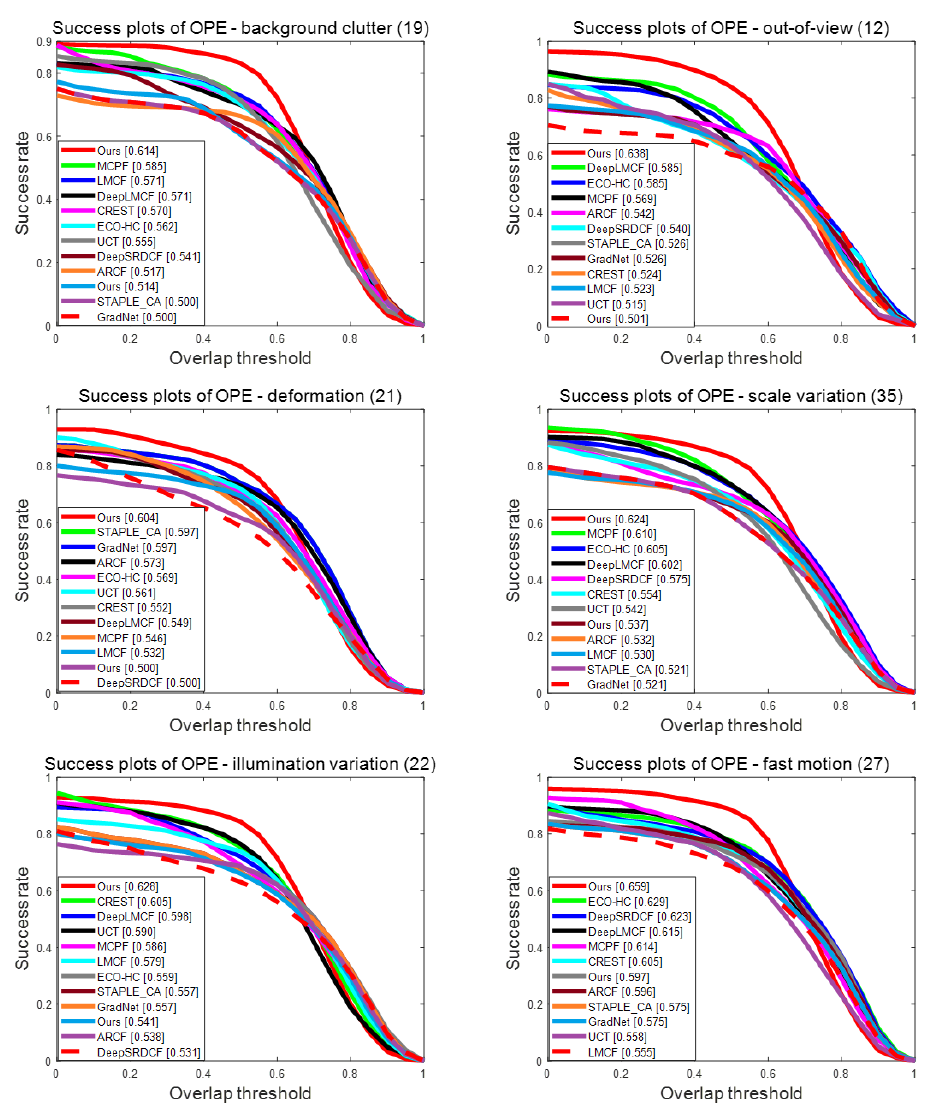
Figure 4. The success plots of the proposed trackers with 6 video attributes on the OTB50